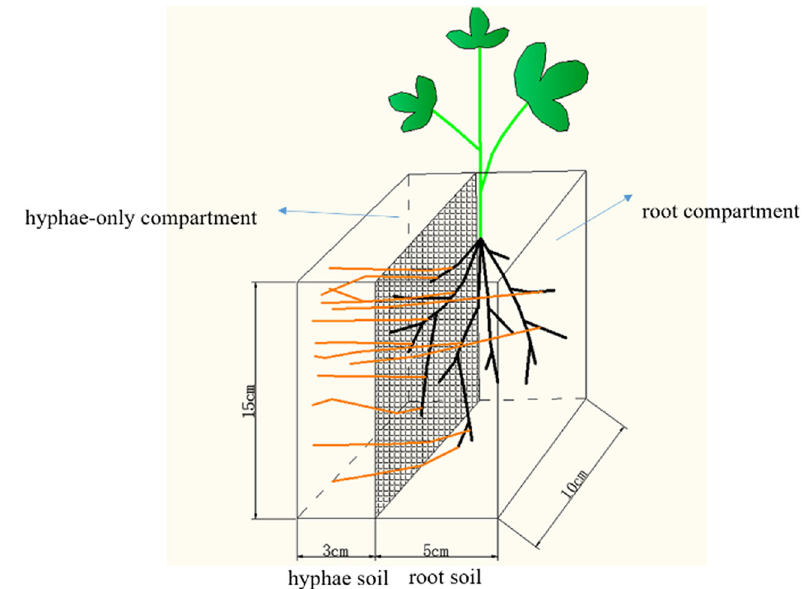
Fig. 1 Two-compartment